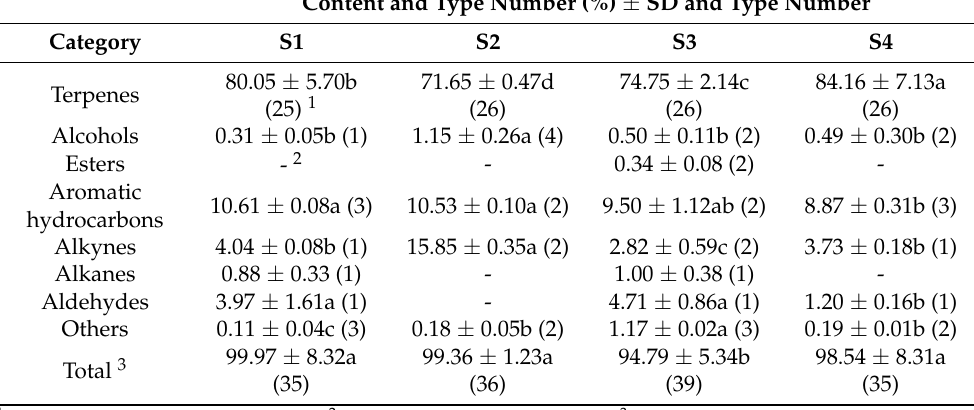
Table 1. Category and content of floral fragrance compounds in the flowers of different P. notoginseng